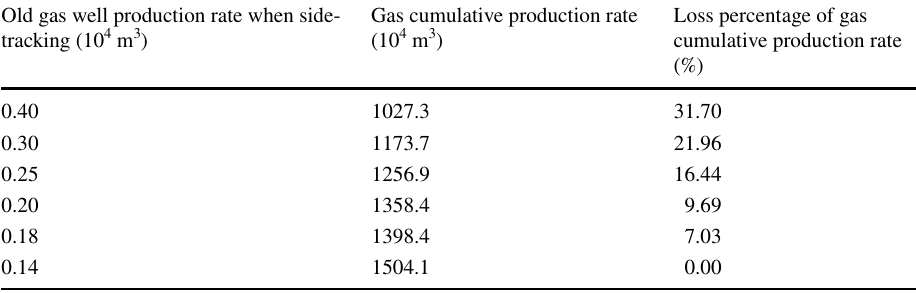
Table 3 Effect of different sidetracked old gas well production rate on gas cumulative production